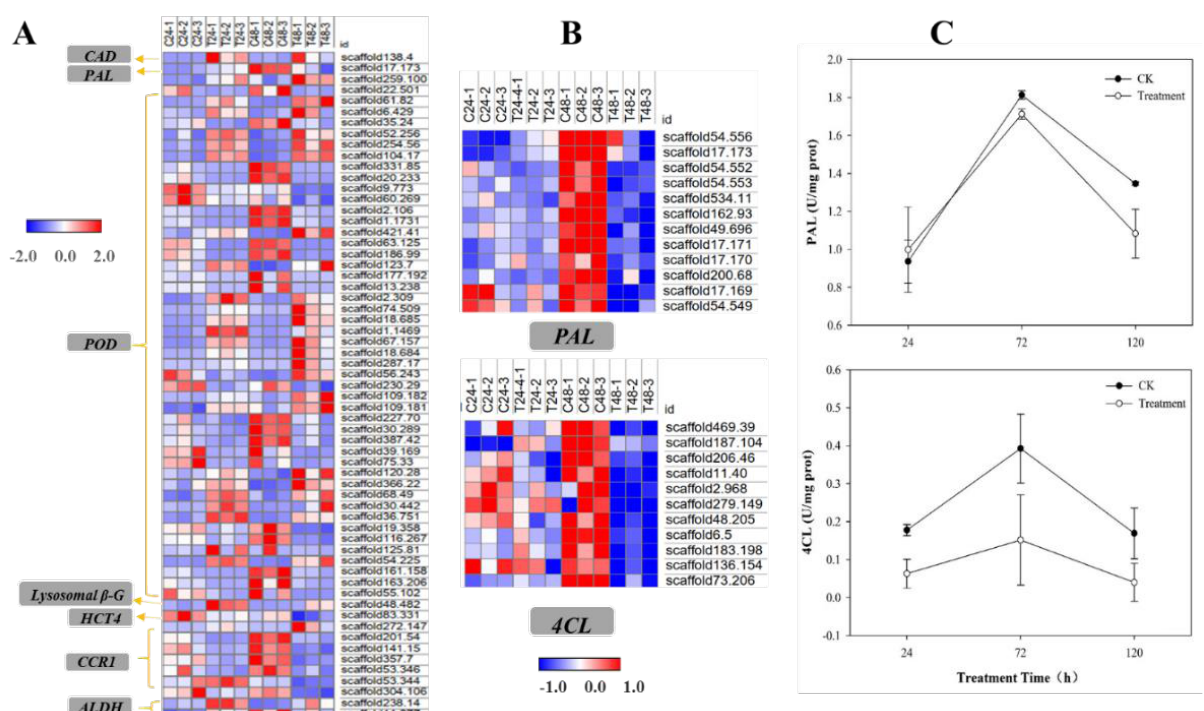
Figure 5. Dihydrocoumarin interferes with phenylpropanoid biosynthesis. ( A ) Differentially ex- pressed gene (DEG) heat map of the phenylpropanoid biosynthesis pathway. The DEGs are defined as |log2FoldChange| > 1 and Padj < 0.05; CAD: cinnamyl alcohol dehydrogenase, PAL : pheny- lalanine ammonia lyase, POD : peroxidase, Lysosomal β -G : lysosome β -glucosidase, HCT4 : hydrox- ycinnamoyl transferase 4, CCR1 : cinnamoyl-CoA reductase 1, and ALDH : acetaldehyde